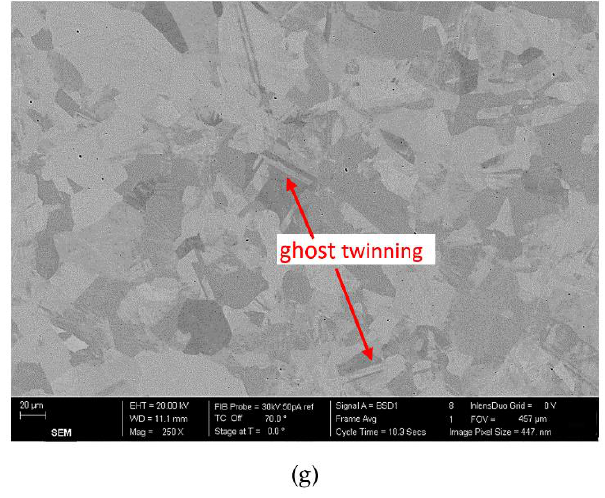
Figure 13. The grain imagery for grade 1.4301 reinforcing bars taken at 250× magnification, including ( a ) the virgin sample, ( b ) the bar exposed to 500 °C and subsequently cooled by quenching in water, ( c ) the bar exposed to 500 °C and subsequently cooled by air cooling, ( d ) the bar exposed to 500 °C and subsequently cooled by slow cooling, ( e ) the bar exposed to 900 °C and subsequently cooled by quenching in water, ( f ) the bar exposed to 900 °C and subsequently cooled by air cooling, and ( g ) the bar exposed to 900 °C and subsequently cooled by slow cooling.